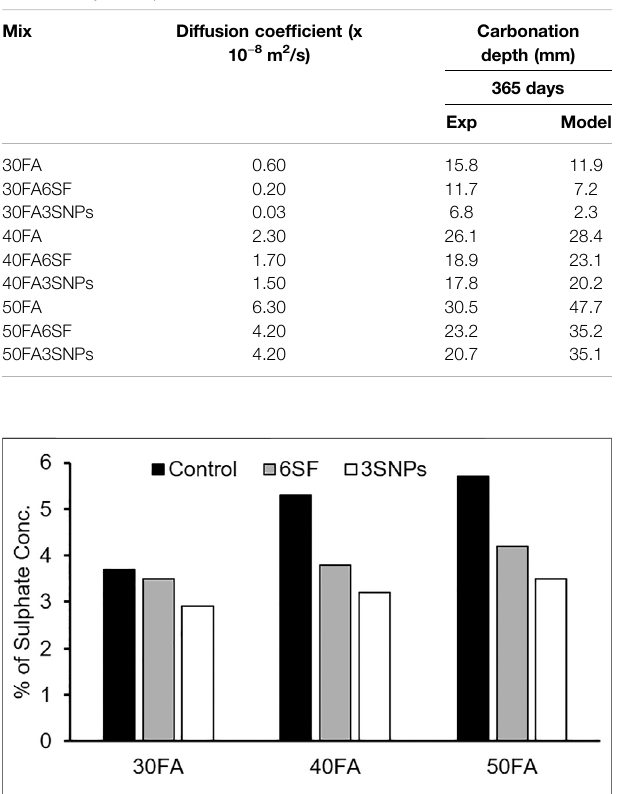
TABLE 6 | Carbonation depth of 3%SNPs and 6% SF incorporated fl y ash concrete specimens with varying the amount of fl y ash 30%, 40%, and 50% after 365 days of exposure.